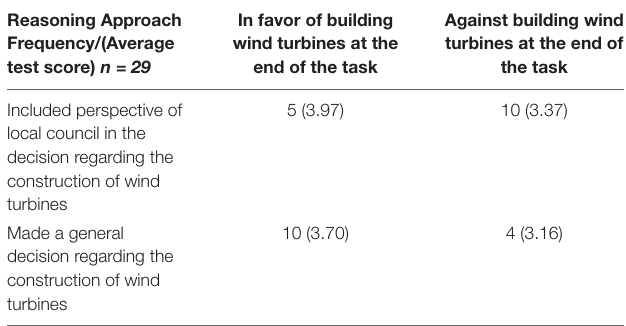
TABLE 5 | Economic- and ecological-focused reasoning and decision against or in favor of wind turbines at the end of the tasks. Reasoning Approach Frequency/(Average